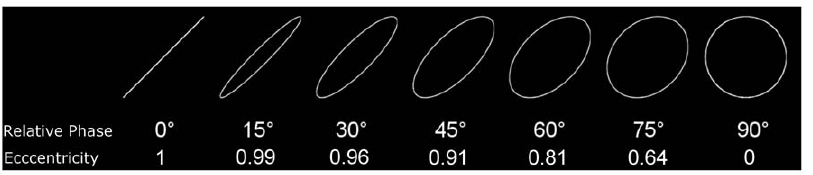
Figure 1. The 7 Standard Ellipses varying between 0 6 and 90 6 of relative phase (RP) by steps of 15 6 used in the discrimination task (with their respective eccentricity provided below the RP